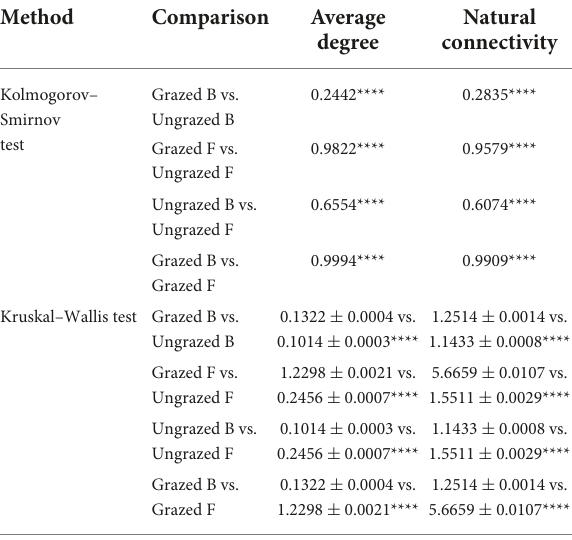
TABLE 2 Results of the Kolmogorov–Smirnov test and Kruskal–Wallis test comparing network stability (average degree and network connectivity) of networks under grazed and ungrazed after 50% nodes were randomly